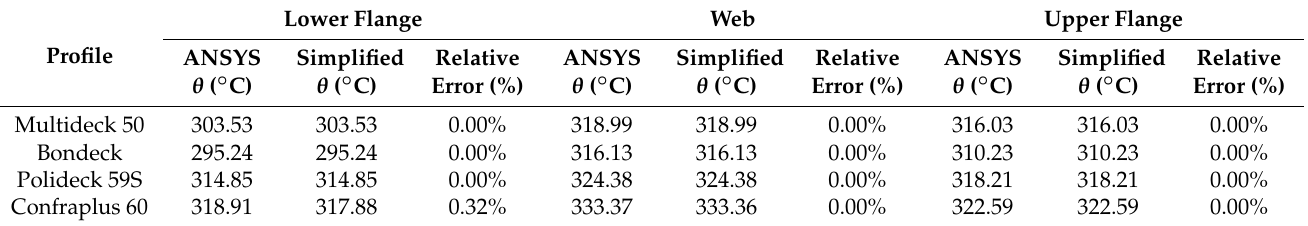
Table 7. Comparison of the temperatures of the numerical model and the simplified method on the steel deck under fire curve Parametric 4 and for the fire rating of 60 min, using the coefficients